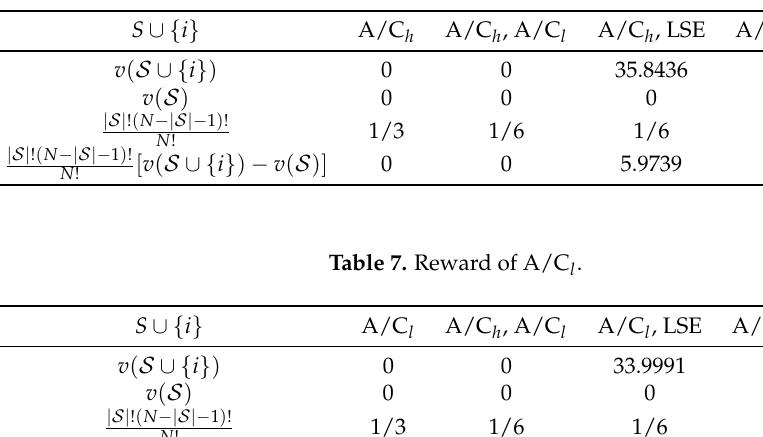
Table 6. Reward of A/C h .